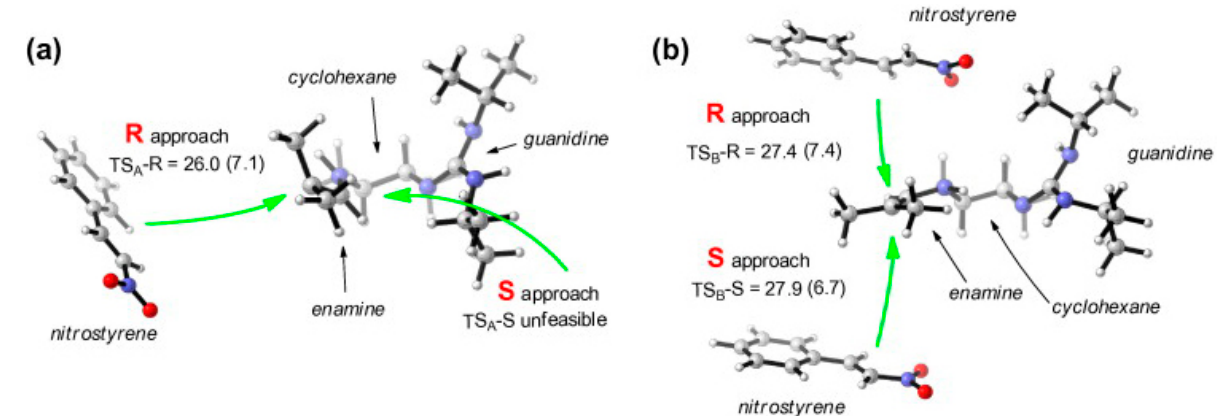
Figure 9. 3D-models for the reaction of nitrostyrene with the two most stable conformations of the enamine, as shown in ( a ) and ( b ), leading to (R)- and (S)- 10 . Free Gibbs energies computed at B3LYP/6-311+G(d,p) (CPCM, water) (M06-2X/6- 311+G(d,p) (SMD, water) in parenthesis) Reprinted and adapted from Tetrahedron: Asymmetry with permission from Elsevier [32].